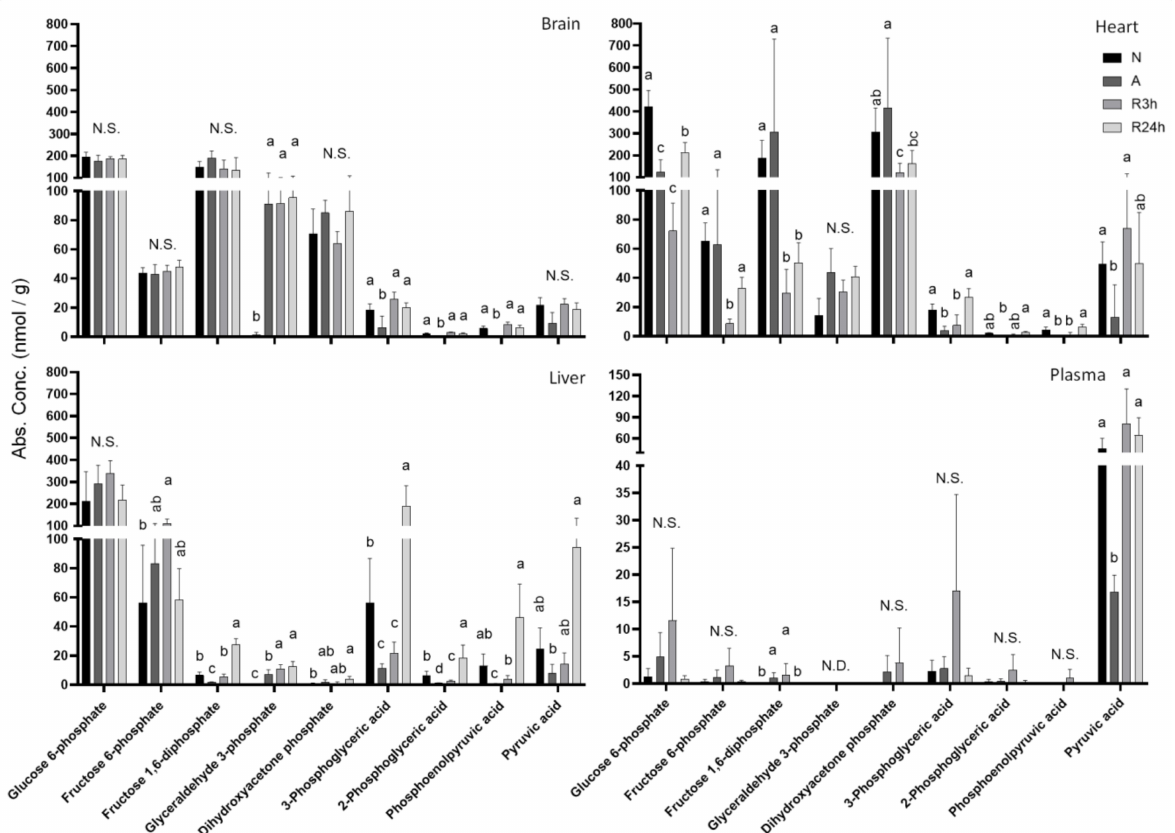
Figure 5. Glycolysis. Graphs of absolute concentrations of detected metabolites involved in glycolysis for brain, heart, and liver. N, normoxia (control); A, anoxia; R3h, 3 h reoxygenation; R24h, 24 h reoxygenation. Different letters indicate statistical differences between groups calculated using one-way ANOVA with Tukey’s post-hoc ( p -value ≤ 0.05). Data are presented as means ± S.D. Values as reported by HMT.